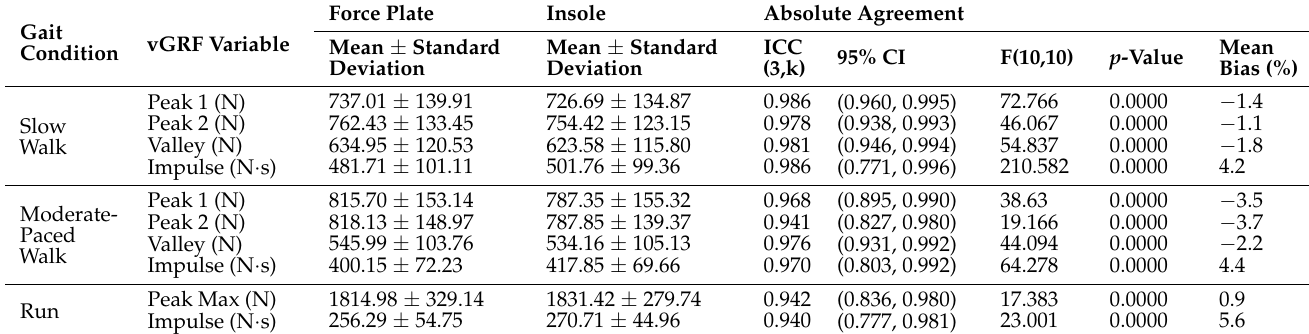
Table 2. Visit 1 agreement between the Insole3 and force plate for each vertical ground reaction force (vGRF) variable during slow walking, moderate-paced walking, and running trials. Absolute agreement between the devices is reported for two-way mixed effects and multiple measurements, with 95% confidence intervals (CI), F-test with p -value, and percent bias. ICC = Intraclass correla- tion